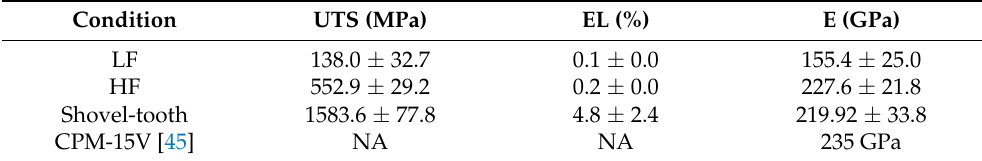
Table 3. Average tensile properties of the LF and HF welds. The statistical significance is based on three repetitions per